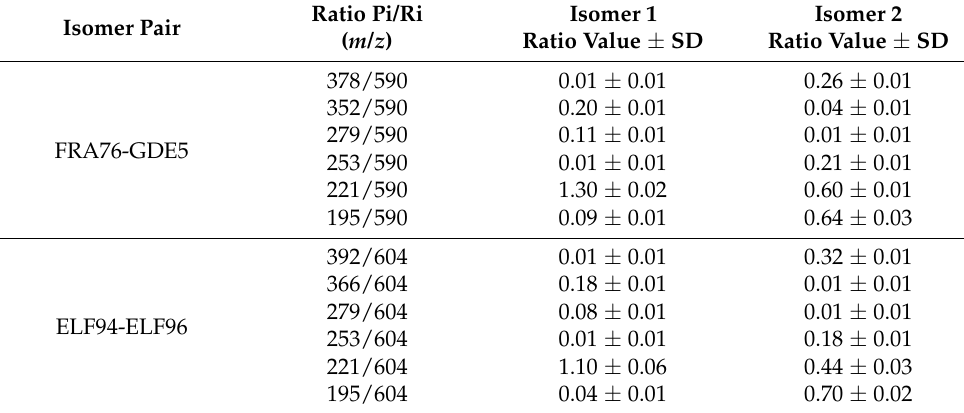
Table 4. Characteristic ion abundance ratios (Pi/Ri) ± standard deviation (SD) calculated by MS/MS data from 100 ng mL − 1 solution of each pure isomer by HPLC-MS/MS methods described in Section